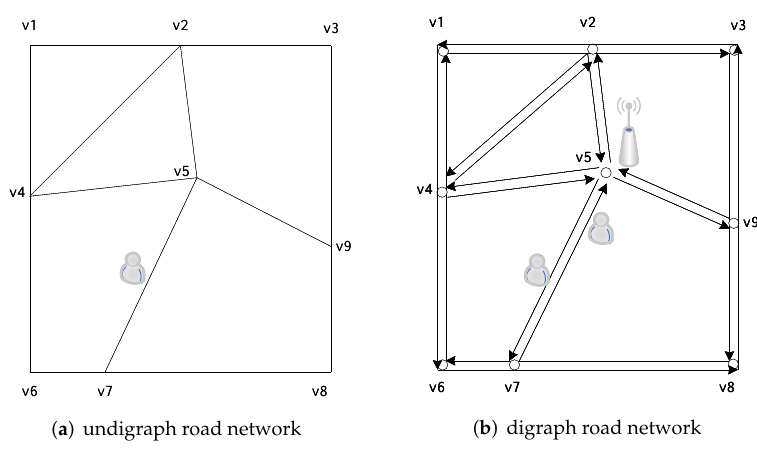
Figure 8. The enhanced DLS.